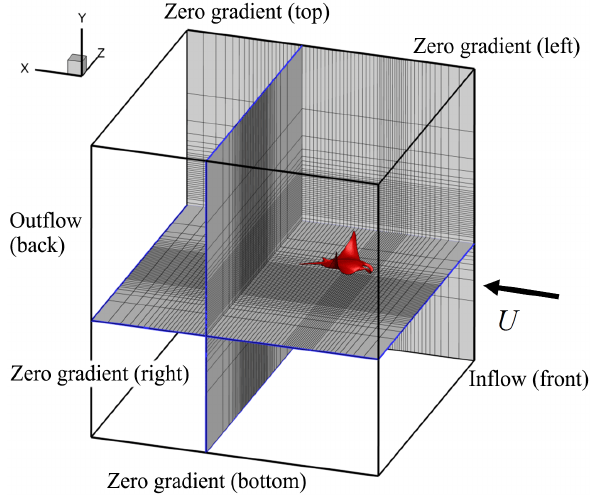
Figure 5. Schematic of the computational mesh and boundary conditions employed in the current simulation. The domain in this schematic was smaller than that of the simulation and one-fourth grid points are shown here.